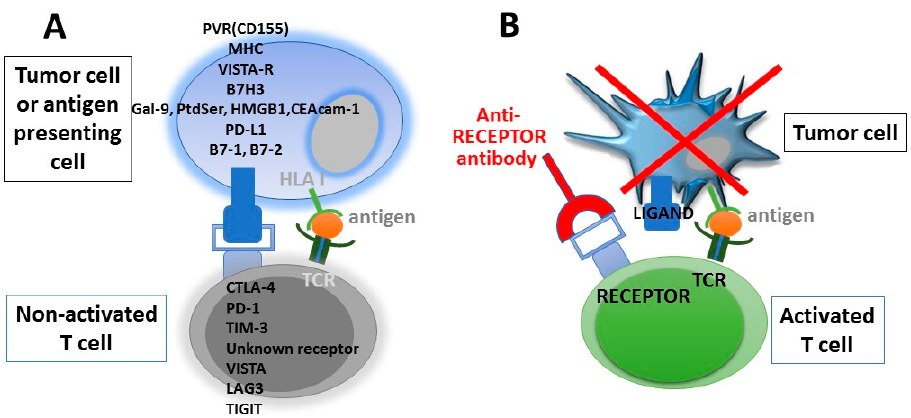
Figure 2. Blocking the immune checkpoint restores the ability of tumor-specific T lymphocytes to kill tumor cells. Antibodies/agents against receptors on T cells (i.e., CTLA-4, PD-1, etc.), and/or their relative ligands (i.e., B7, PDL-1, etc.) on antigen presenting cells or tumor cells re-activate pre-existing anti-tumor T cells that can induce tumor cell killing. Recognition of the human leukocyte antigen (HLA) Class I/peptide antigen complex by the T-cell receptor present on T cells is required to induce tumor cell killing; ( A ) Inhibitory receptor/ligand interaction is not blocked and the tumor cell is not killed; ( B ) the immune checkpoint receptor is blocked by an inhibitory antibody and the T-cell is re-activated and is thus able to kill tumor cells. PVR: poliovirus Receptor; MHC: Major Histocompatibility Complex; VISTA: V-domain Ig suppressor of T cell activation; VISTA-R: VISTA Receptor; Gal-9: Galectin-9; PtdSer: Phosphatidylserine; HMGB1: High Mobility Group Box 1; CEAcam-1: Carcinoembryonic antigen-related cell adhesion molecule 1; PD-L1: Programmed death-ligand 1; CTLA-4: Cytotoxic T-Lymphocyte Antigen 4; PD-1: PD-L1: Programmed death 1; TIM-3: T cell immunoglobulin and mucin domain 3; LAG-3: Lymphocyte-activation protein 3; TIGIT: T-cell immunoreceptor with Ig and ITIM domains.